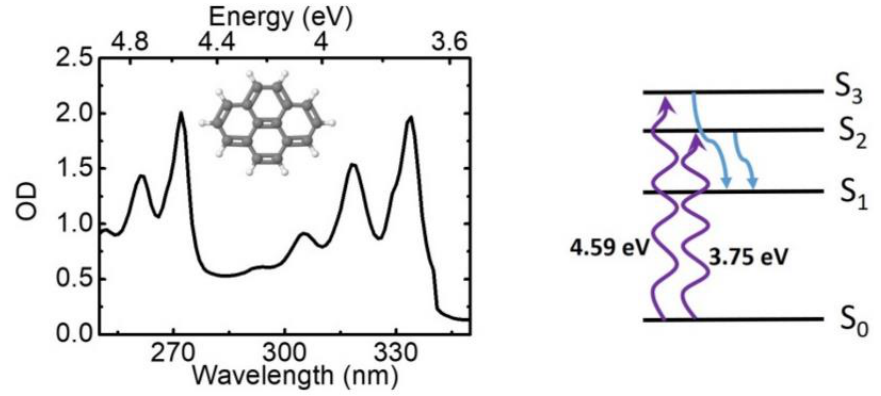
Figure 6. Chemical structure (inset) and linear absorption spectrum of pyrene dissolved in methanol; schematic of energy level structure of pyrene, and the internal conversion processes after excitation in the UV.